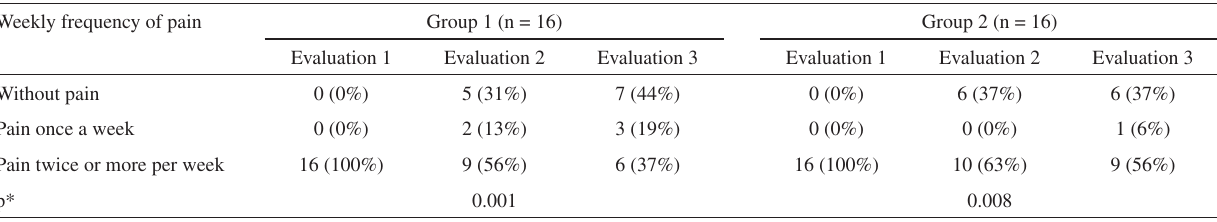
Table 1 – Weekly periodicity of pain symptoms in group 1 (conventional physiotherapy) and group 2 (shockwave physio- therapy) before treatment, immediately afterwards, and three months later